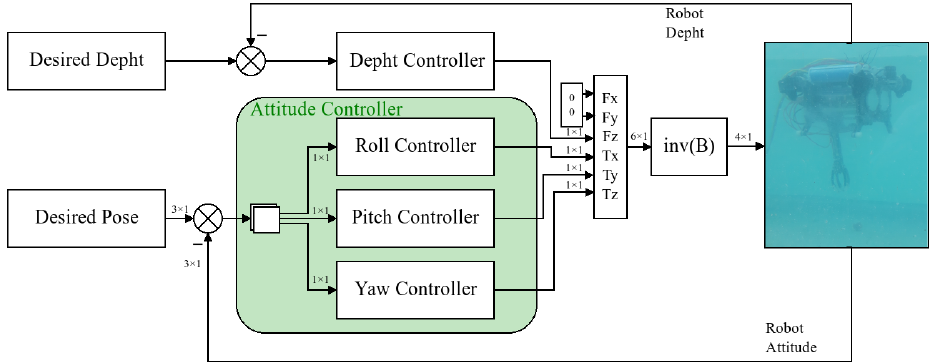
Figure 11. Control schema describing the disengagement of controllers, where B is the thruster allocation matrix, and the desired position is in Euler angles.